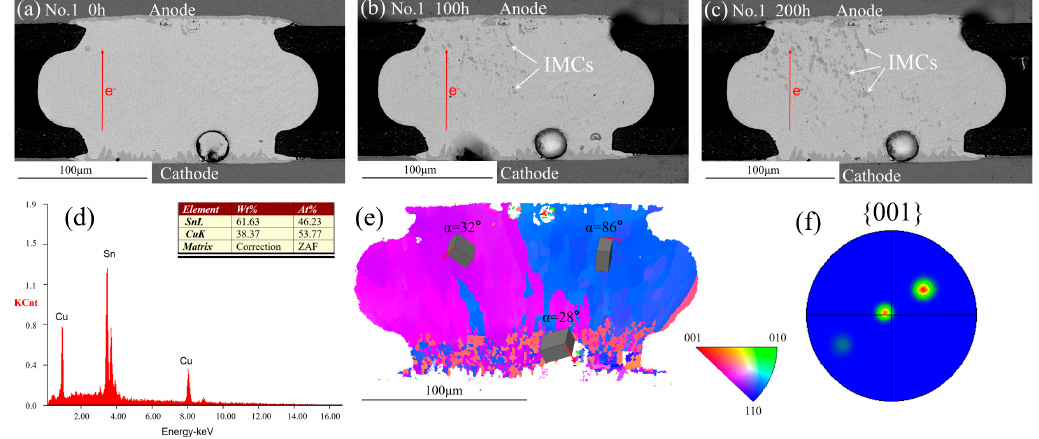
Figure 5. SEM images of the No.1 solder joint after different current stressing times: ( a ) 0 h; ( b ) 100 h; ( c ) 200 h; ( d ) the EDS results of IMCs; ( e ) EBSD map of the No.1 solder joint after reflow; ( f ) pole figure of {001} plane.